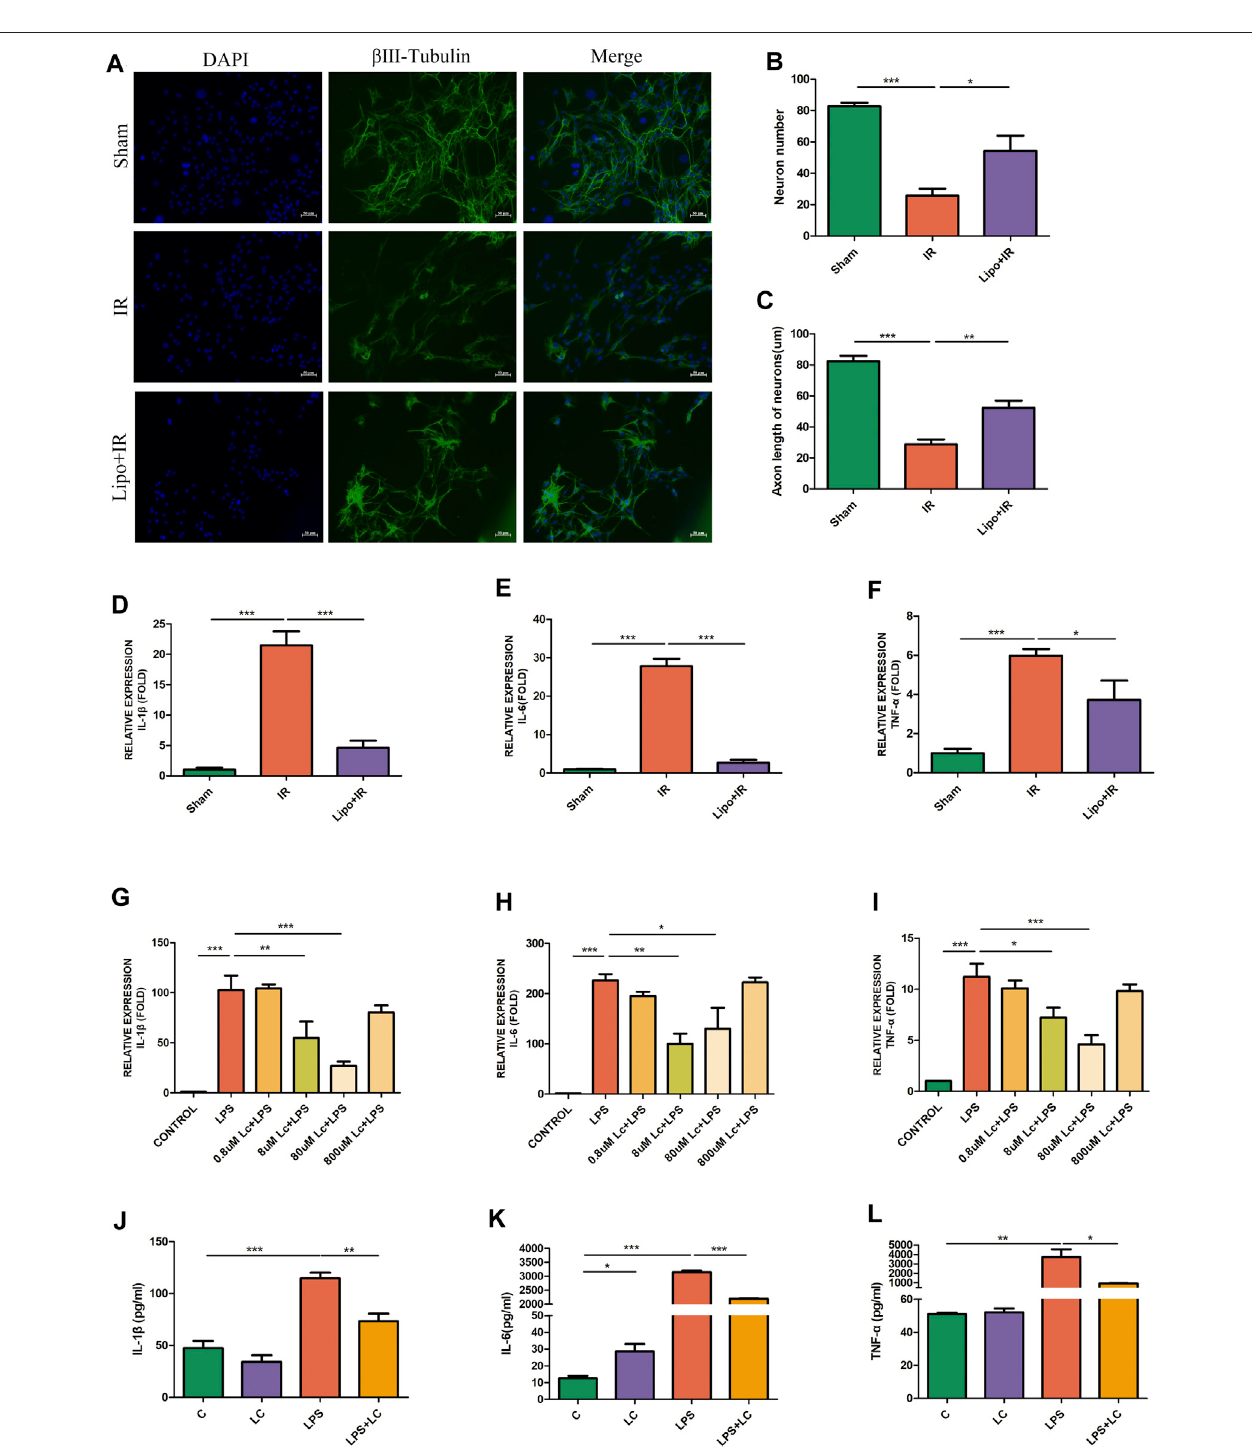
FIGURE2| MacrophageswereinvolvedintheprotectioneffectofL-CysontheinjuryofmyentericneuronsafterintestinalIR.ClodronateorControlliposomeswere i.p. injected the day before the establishment of the mouse intestinal IR model. (A) Representative photographs of immuno fl uorescent staining of β Ⅲ -tubulin (green) and DAPI (blue) among four groups. Scale bar = 50 μ m. N = 4 /group. (B,C) Quantitative analyses of the number of neurons and the length of axons. Six randomly captured imagesper animal were analyzed for each group. N = 4 /group. (D – F) The mRNA levels ofpro-in fl ammatory factors IL-1 β , IL-6, and TNF- α in LMMP weredetected by qRT-PCR. N = 4 /group. (G – I) After L-Cys (from 0.8 to 800 μ M) in coordination with LPS (100 ng/ml)-stimulated RAW264.7 cells, the mRNA levels of IL-1 β , IL-6, and TNF- α weredetected. N=4 /group. (J – L) Proteinlevelsofpro-in fl ammatoryfactorsIL-1 β ,IL-6,andTNF- α weredetectedbypreincubatingRAW264.7cellswith8 μ M L- Cys using ELISA. N = 4 /group. Values are mean ± SEM , * p < 0.05, ** p < 0.01, and *** p < 0.001 according to ANOVA with the Newman – Keuls test.